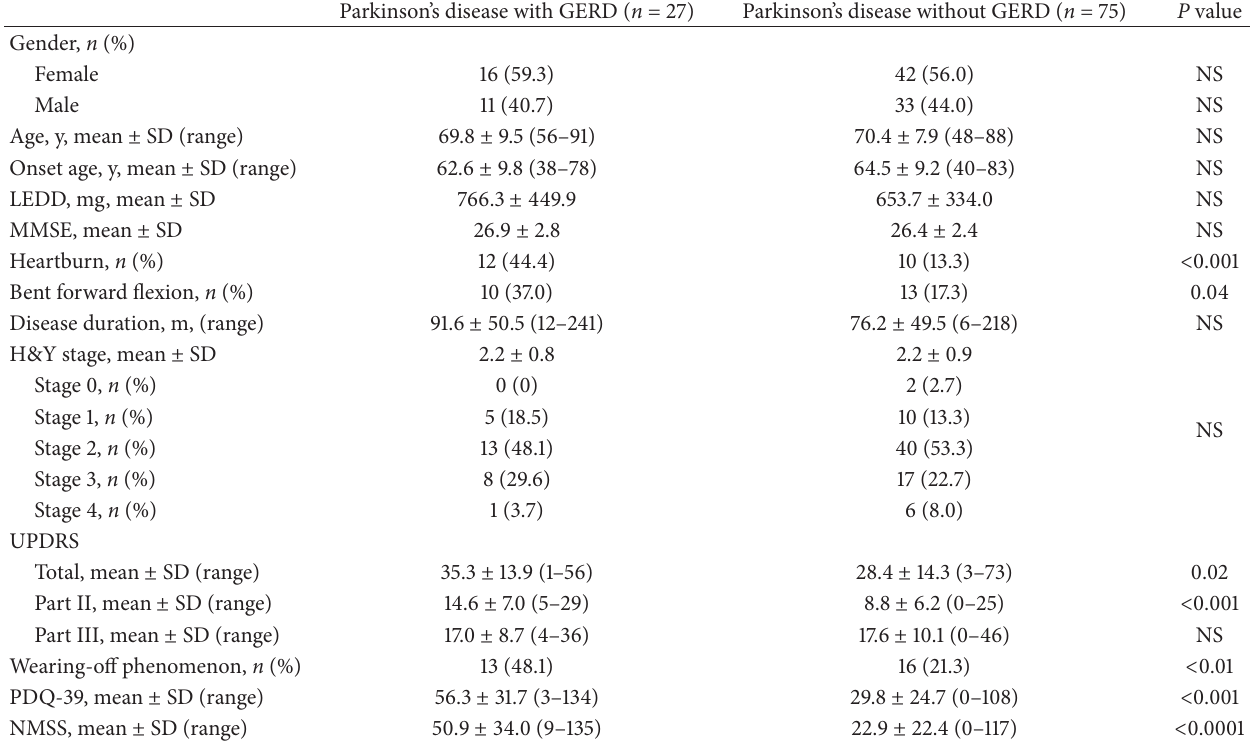
Table 3: Demographic characteristics of Parkinson’s disease with or without GERD.